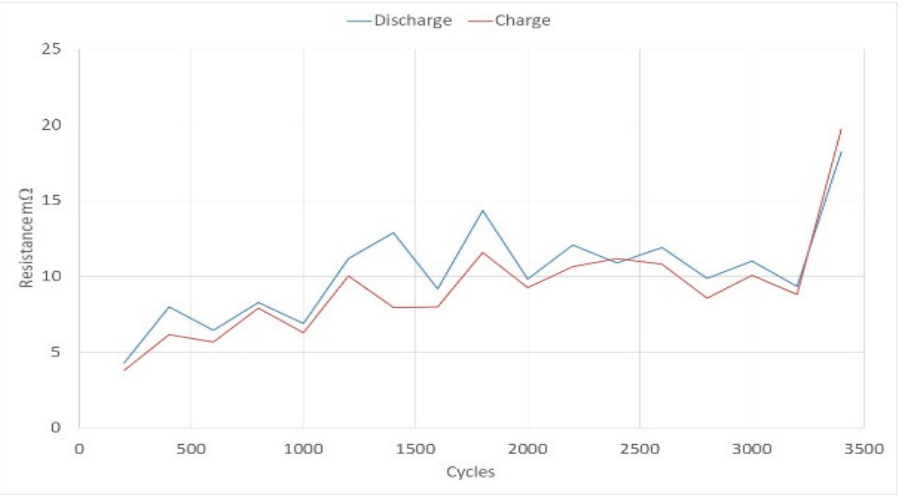
Figure 3. Internal resistance variation with aging for SOC (State of Charge) = 50%.